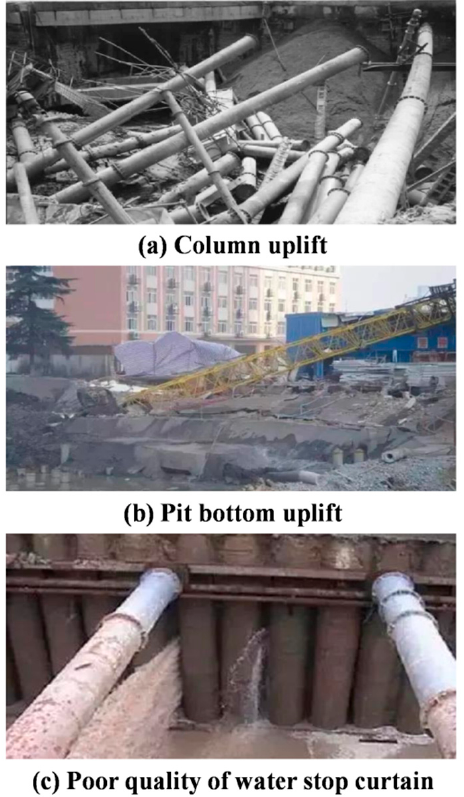
Figure 7. Environmental risks affecting steel bracing systems.